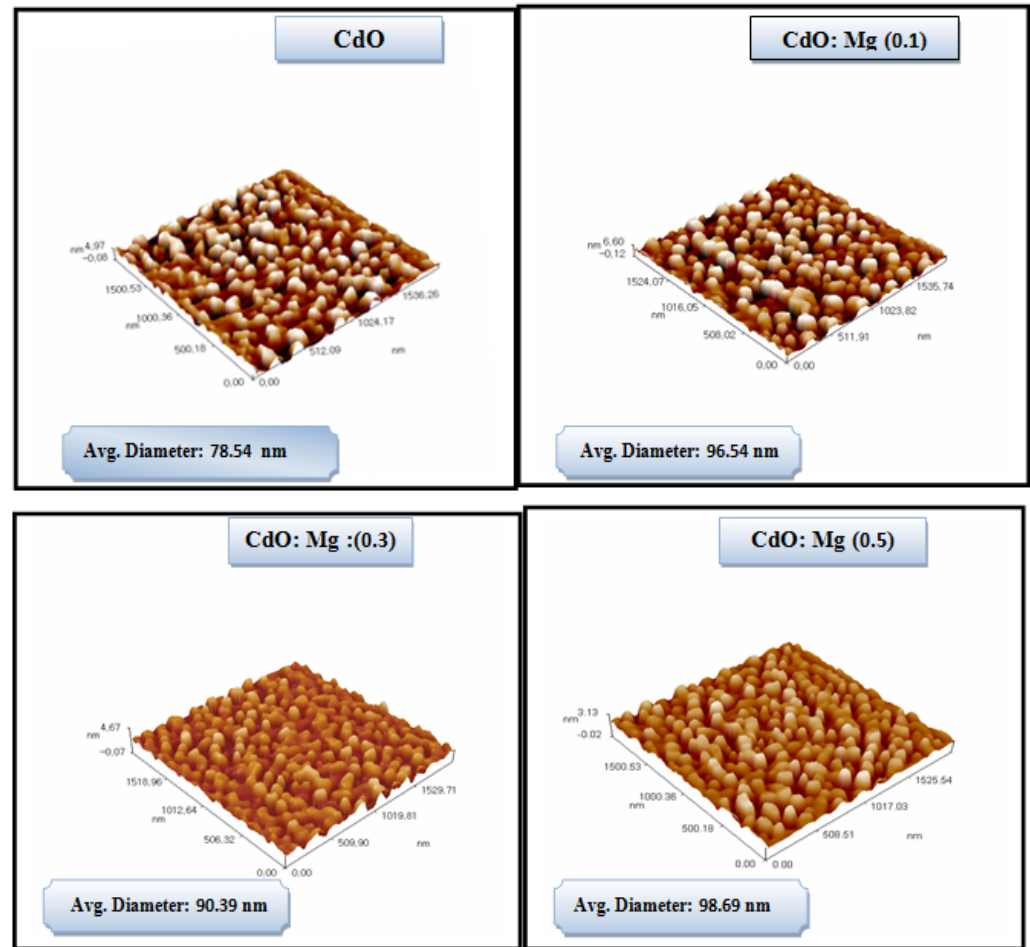
Fig.3: Three-dimensional images of (CdO: Mg) films and of various distortion